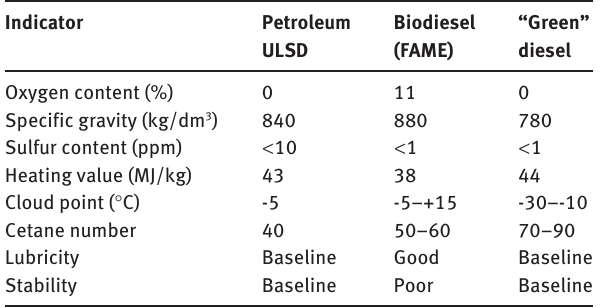
Table 1 Comparison of the main characteristics of diesel, biodiesel and “green” diesel